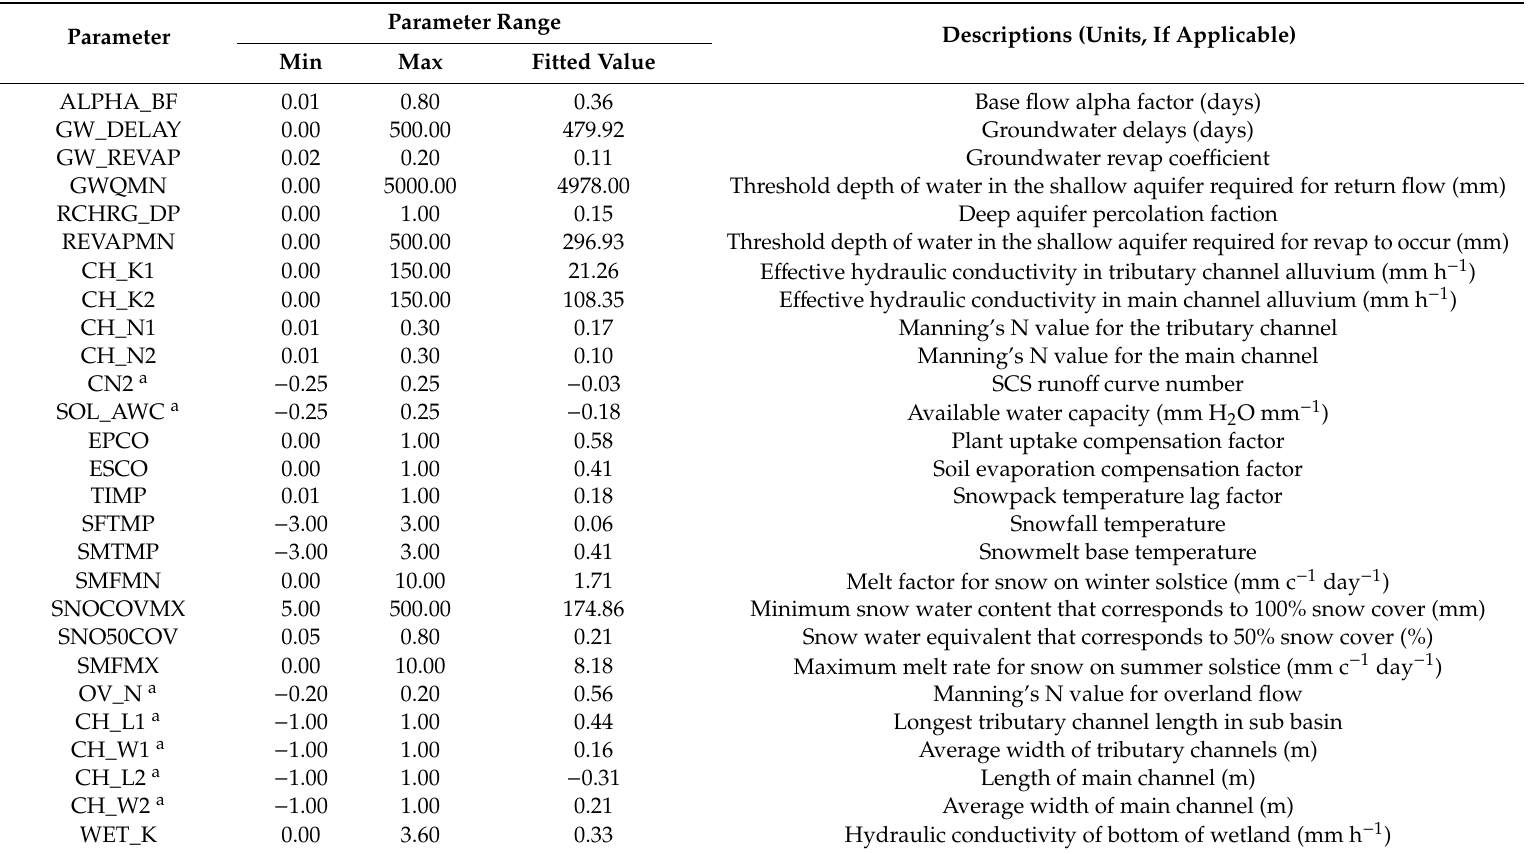
Table 3. Initial and final calibrated parameters for the Shellmouth reservoir catchment in the Upper Assiniboine River Basin